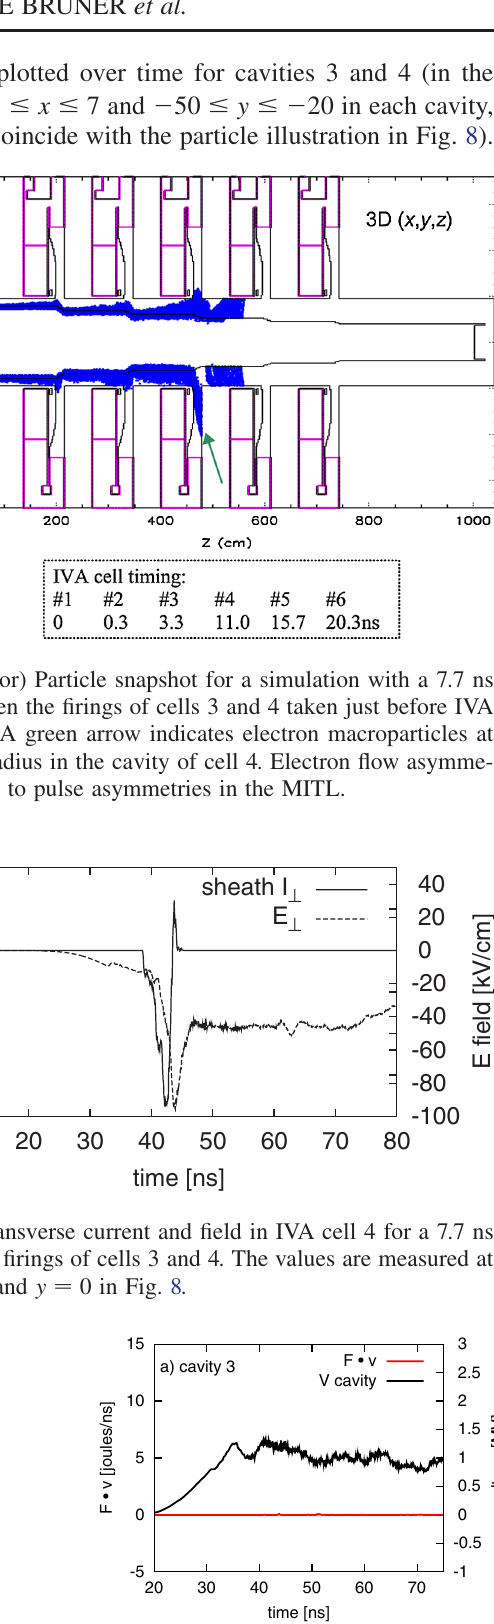
FIG. 10. (Color) Energy exchange ( F (cid:2) v p ) between electrons and the electric field recorded in cavities 3 (a) and 4 (b) for a simulation with a 7.7 ns delay between the firings of those cells. The cell voltages recorded inside the cell cavity ( x ¼ 30 cm , y ¼ 0 ) are also